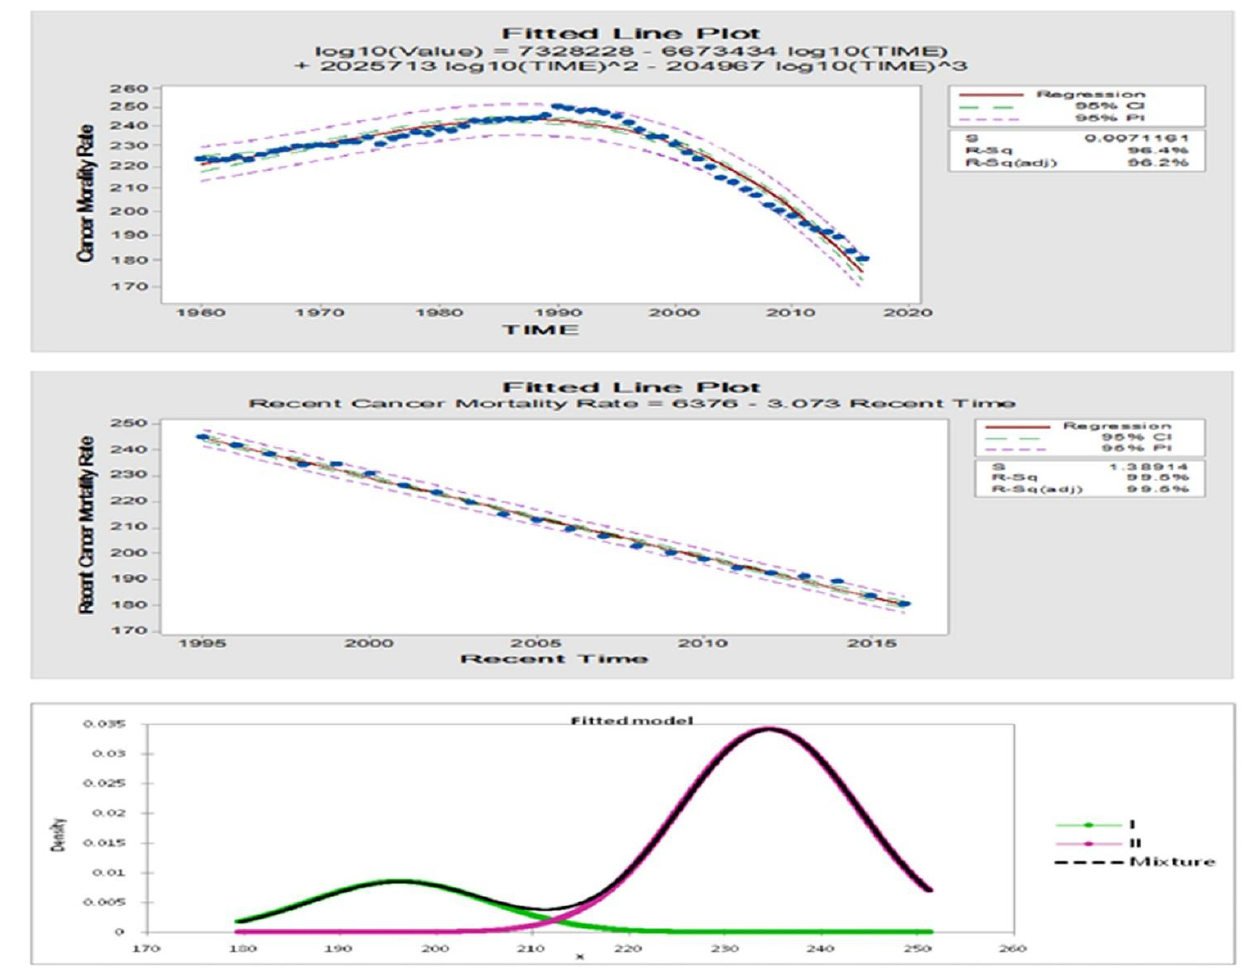
Figure 2: Fitted line plot showing confidence interval (CI) and predictor interval (PI) at 95% confidence level: of logarithmic transformation to base ten with cubic regression model type for overall trend (upper graph), linear regression model type for the descending part of the curve (middle graph)and GMM showing cancer mortality rates trend as interfering two bell-shaped distributions analyzed as best fitted model (lower